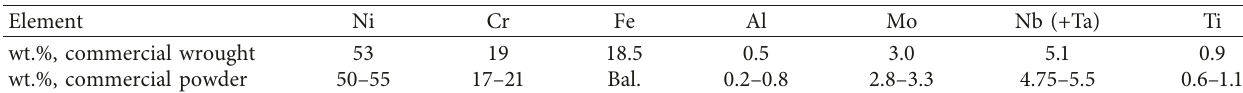
Table 1: Chemical composition of a commercial wrought solution-treated IN718 [17] and the commercial IN718 powder used in this study (specifications from the supplier).